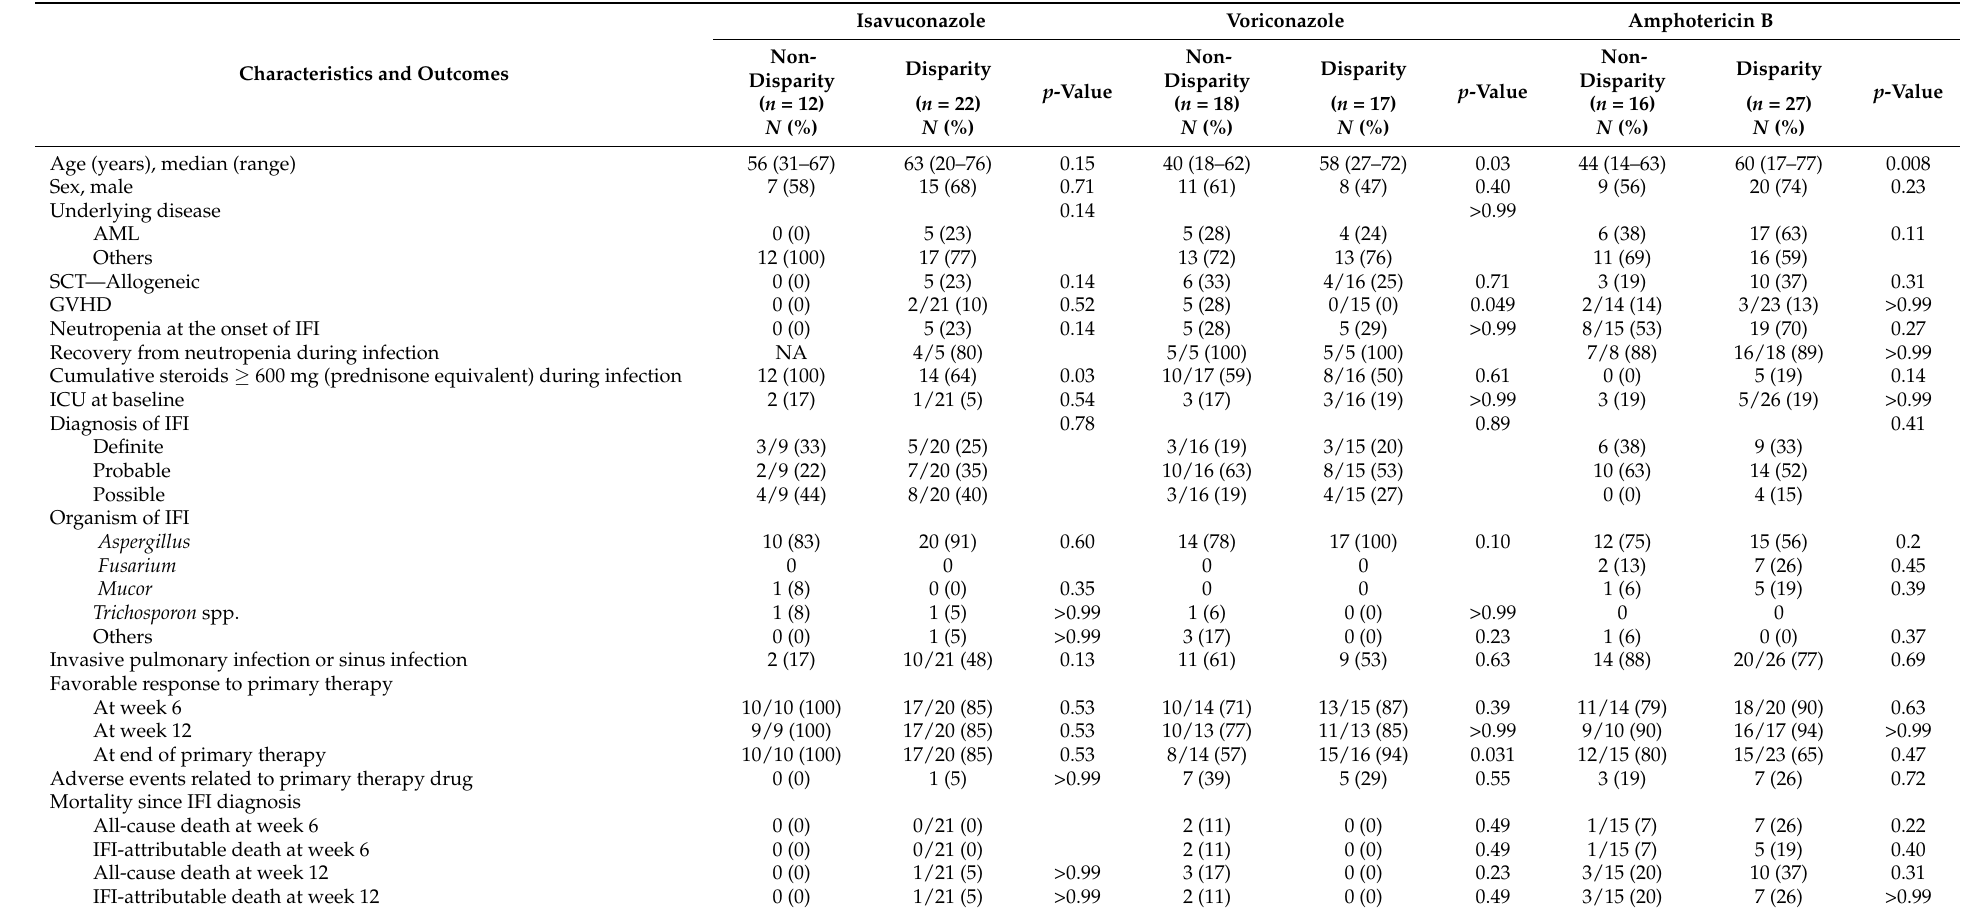
Table 4. Comparing patients with and without disparity by primary